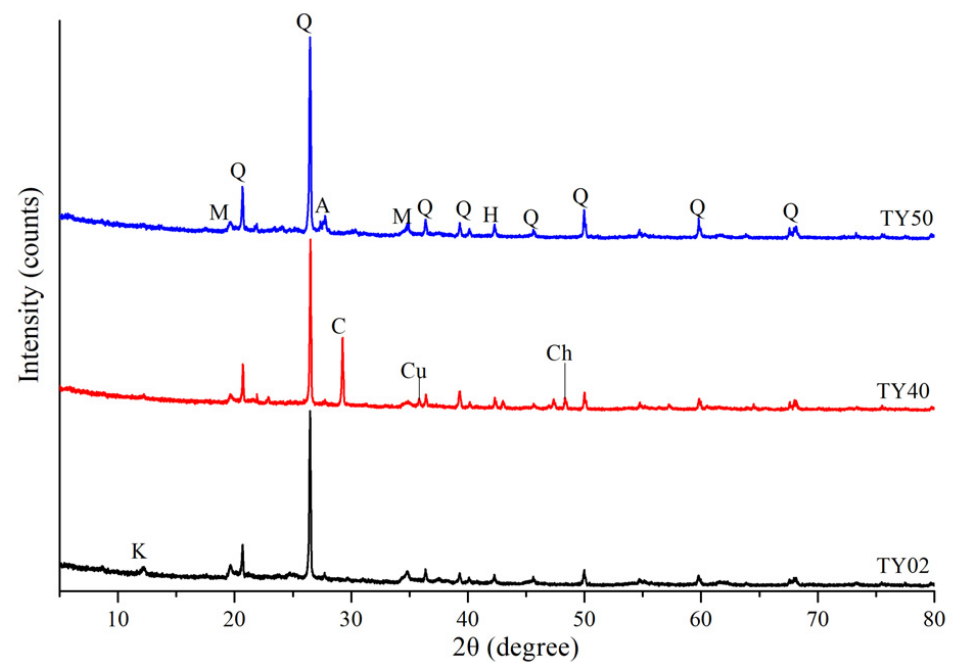
Figure 2. The X-ray diffraction patterns of soils. A—albite; C—calcite; Ch—chalcocite; Cu—cuprite; H—hematite; K—kaolinite; M—muscovite; Q—quartz.